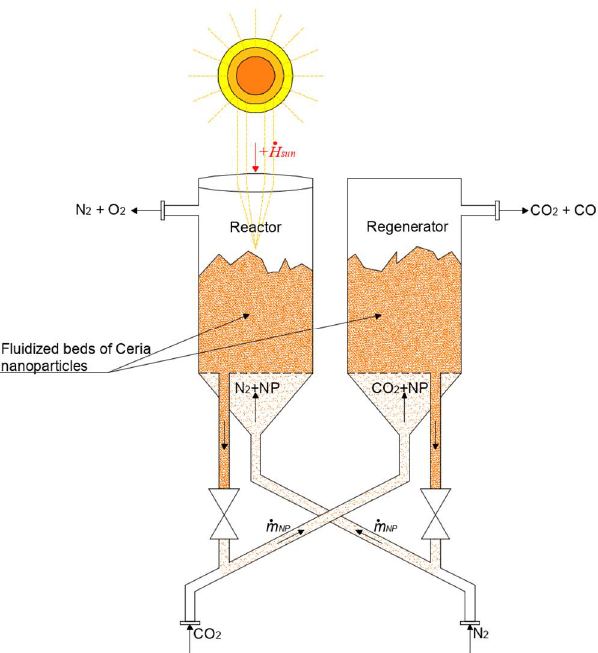
Figure 1. Schematic model of double-loop fluidized bed solar reactor, for thermochemical fuel production.